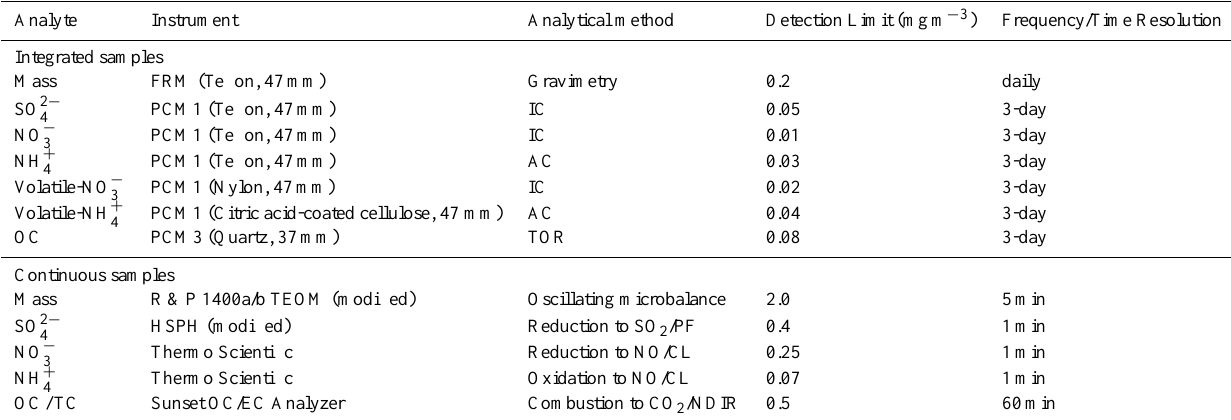
Table 3. Summary of integrated, semi-continuous, and continuous PM 2 . 5 analyses at JST.